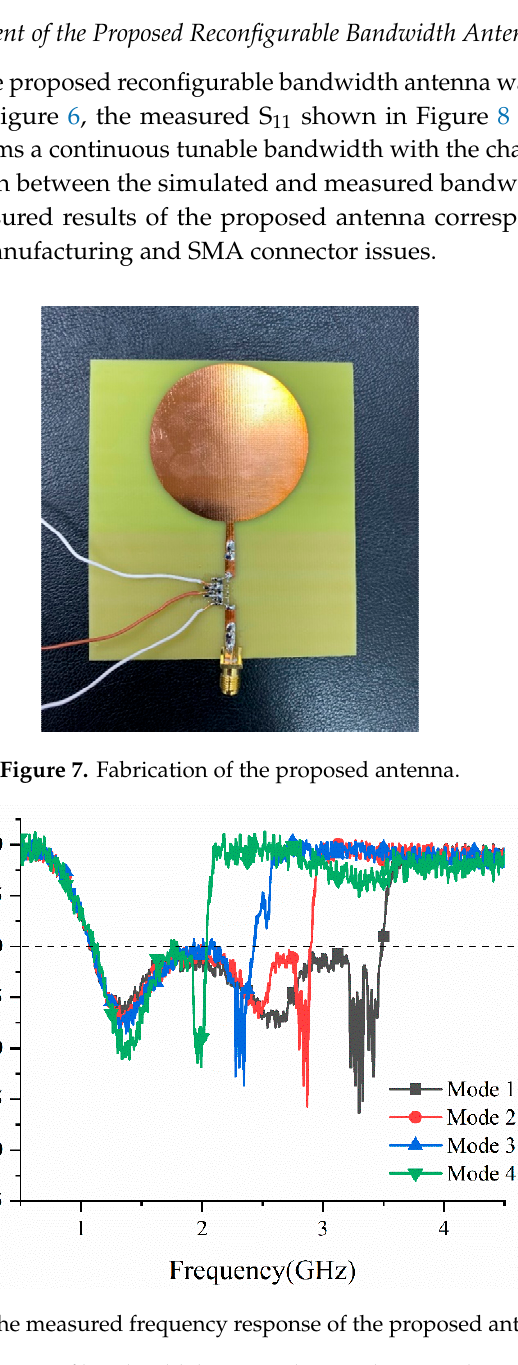
Figure 6. The simulated frequency response of the proposed antenna for each mode.